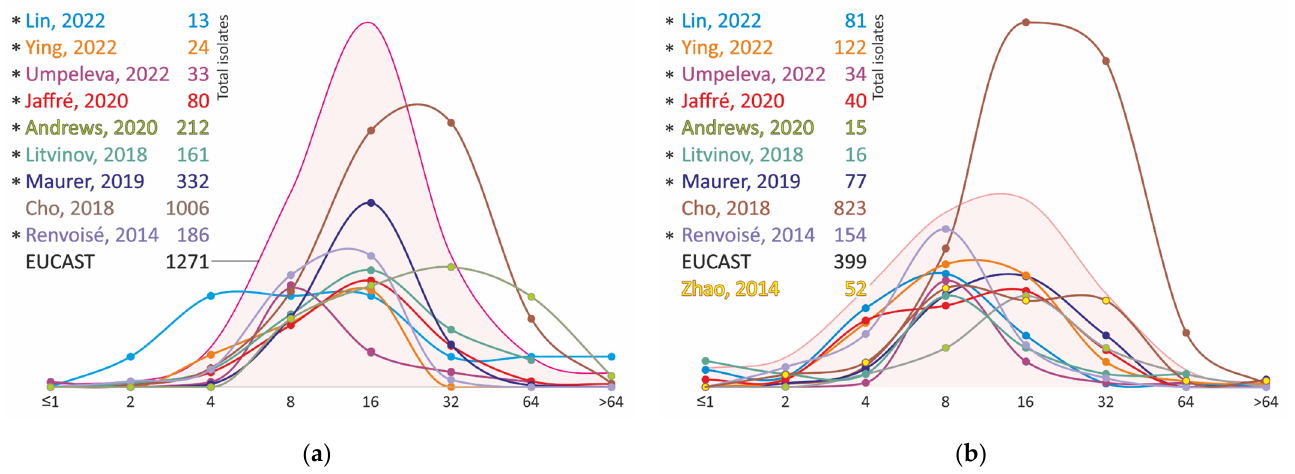
Figure 7. Amikacin MIC distribution for clinical M. avium ( a ) and M. intracellulare ( b ) isolates. *—MIC obtained using Sensititre SLOMYCO plates.